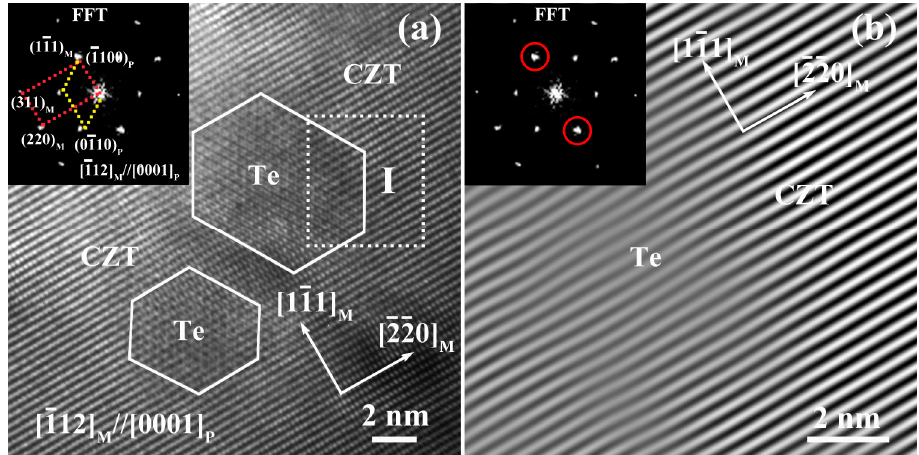
[112] zone axis. ( a ) The (cid:2) (cid:3) 112 zone axis. ( a ) The M M